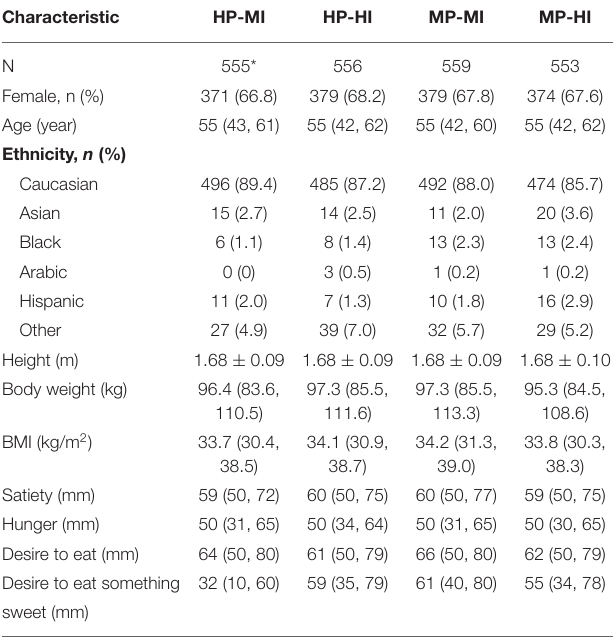
Values represent mean ± SD for normally-distributed variables or median (25th, 75th percentiles) for non-normally-distributed variables or the number of participants (%) for categorical variables. * A total of 556 individuals were randomized to the HP-MI group, but one of them withdrew consent and requested data deletion. BMI, body mass index; HP- MI, high protein-low glycemic index diet, moderate intensity physical activity; HP-HI, high protein-low glycemic index diet, high intensity physical activity; MP-MI, moderate protein- moderate glycemic index diet, moderate intensity physical activity; MP-HI, moderate protein-moderate glycemic index diet, high intensity physical